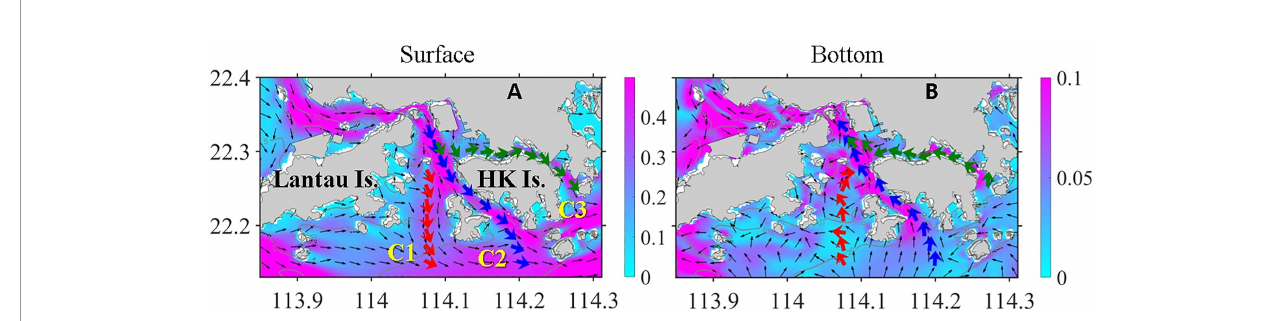
FIGURE 3 | Simulated velocity (m s − 1 ) fi eld at (A) surface and (B) bottom layer averaged from day 38 to day 45. The color contours indicate the magnitude of velocity, and thin black arrows show the direction of velocity. The thick red, blue, and green arrows represent the horizontal integrated velocity in channels C1 – 3,